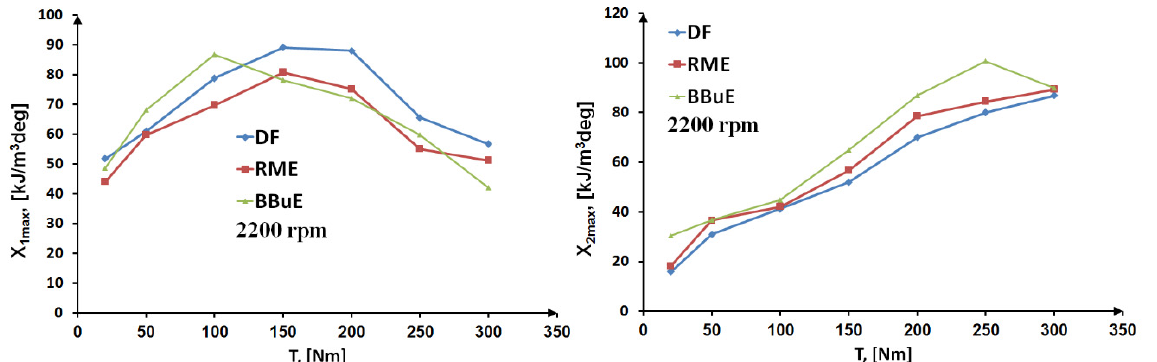
Figure 14. Maximum values of the first rate of heat release during the combustion process occurring according to the kinetic mechanism x 1max and the second rate of heat release during the combustion process occurring according to the diffusion mechanism x 2max when the engine is operated according to the load characteristics at a crankshaft speed of 2200 rpm and fed with the tested fuels.